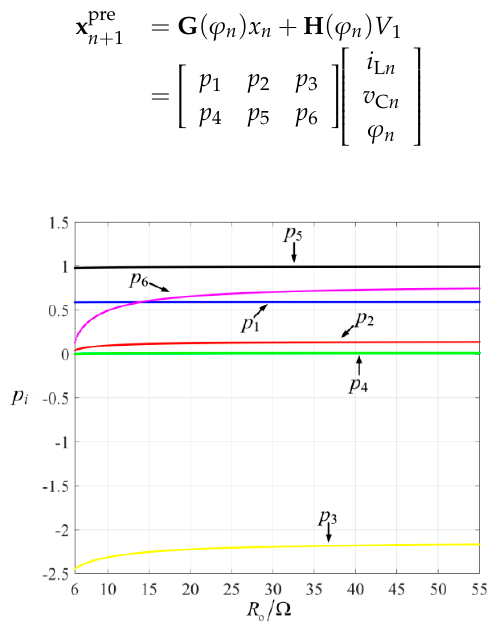
Figure 12. Sensitivity of the predictive algorithm coefficients to the load change.